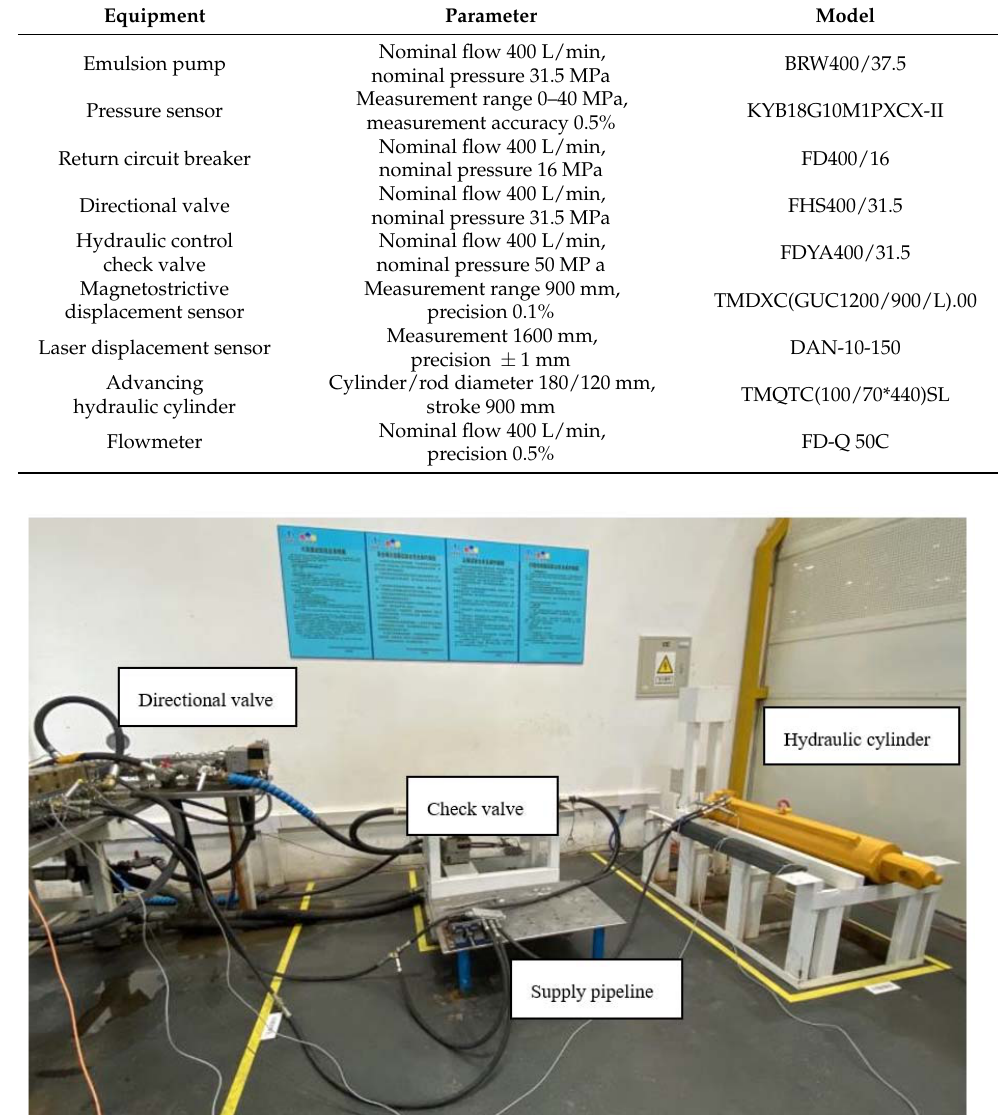
Figure 4. Connection diagram of the hydraulic system of advancing hydraulic cylinder.